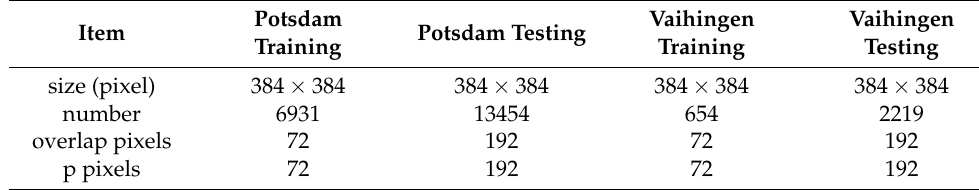
Table 2. Parameters of the experimental